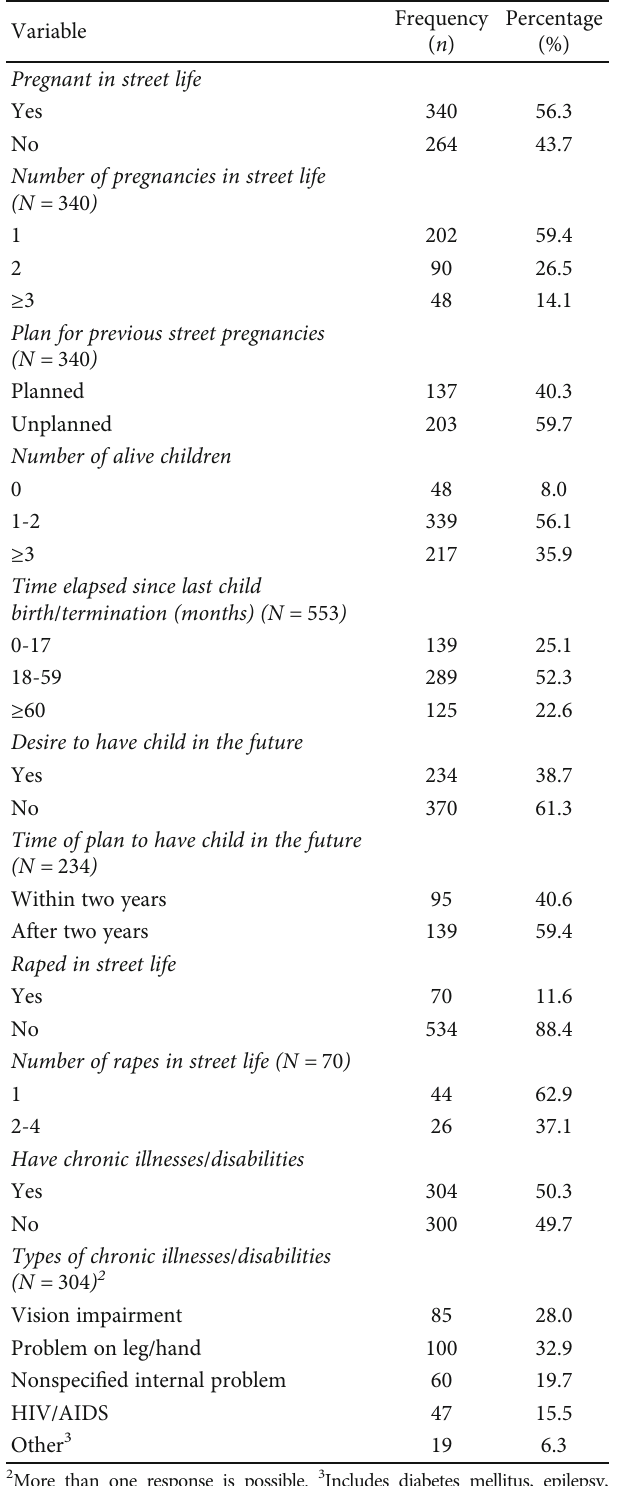
Table 2: Reproductive and other health-related characteristics of respondents in Amhara regional state zonal towns, North West Ethiopia, 2019 ( N = 604